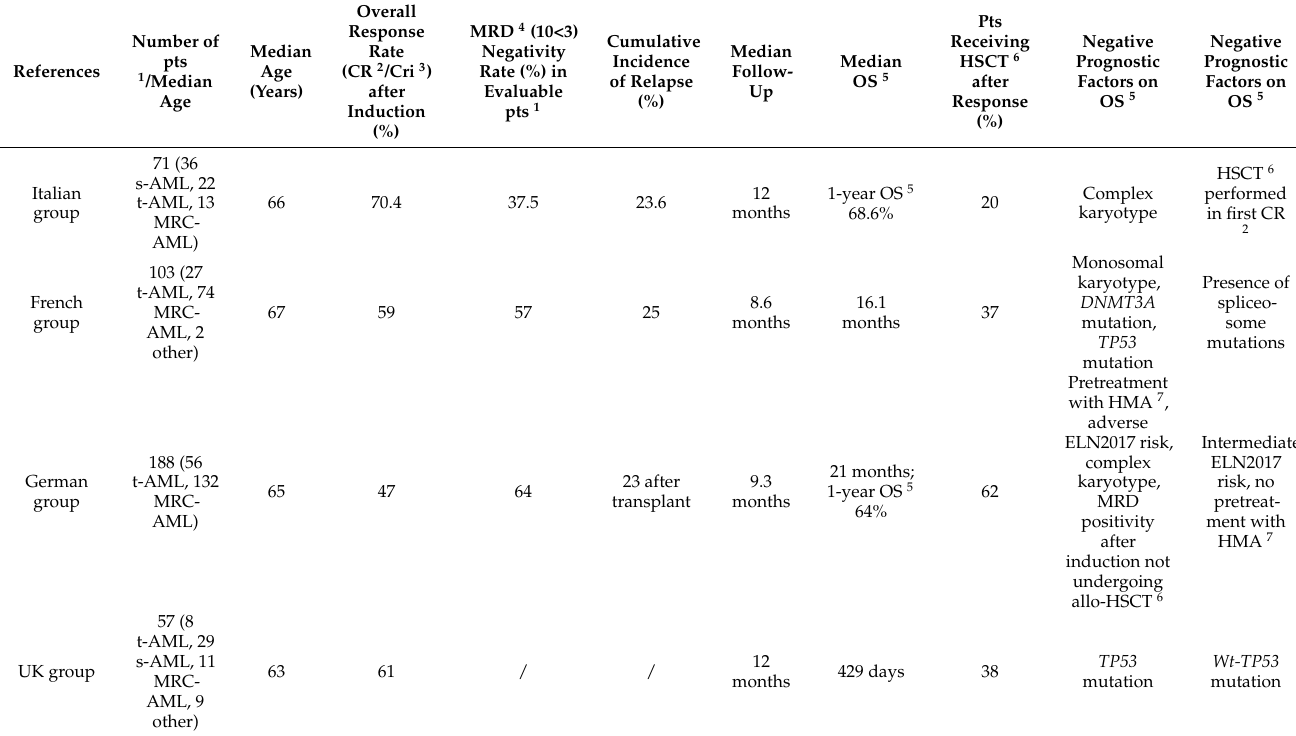
Table 2. Real-life experiences with